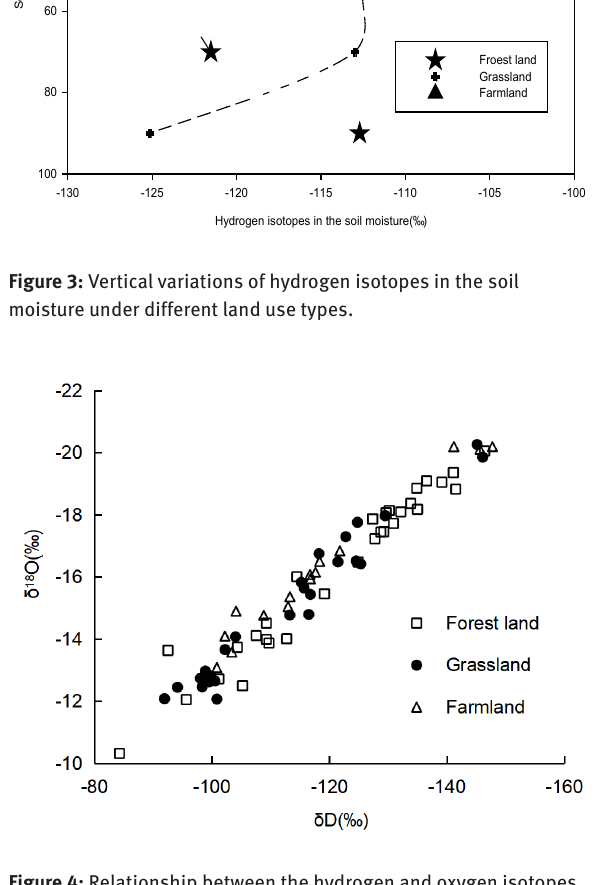
Figure 4: Relationship between the hydrogen and oxygen isotopes of soil moisture under different land use